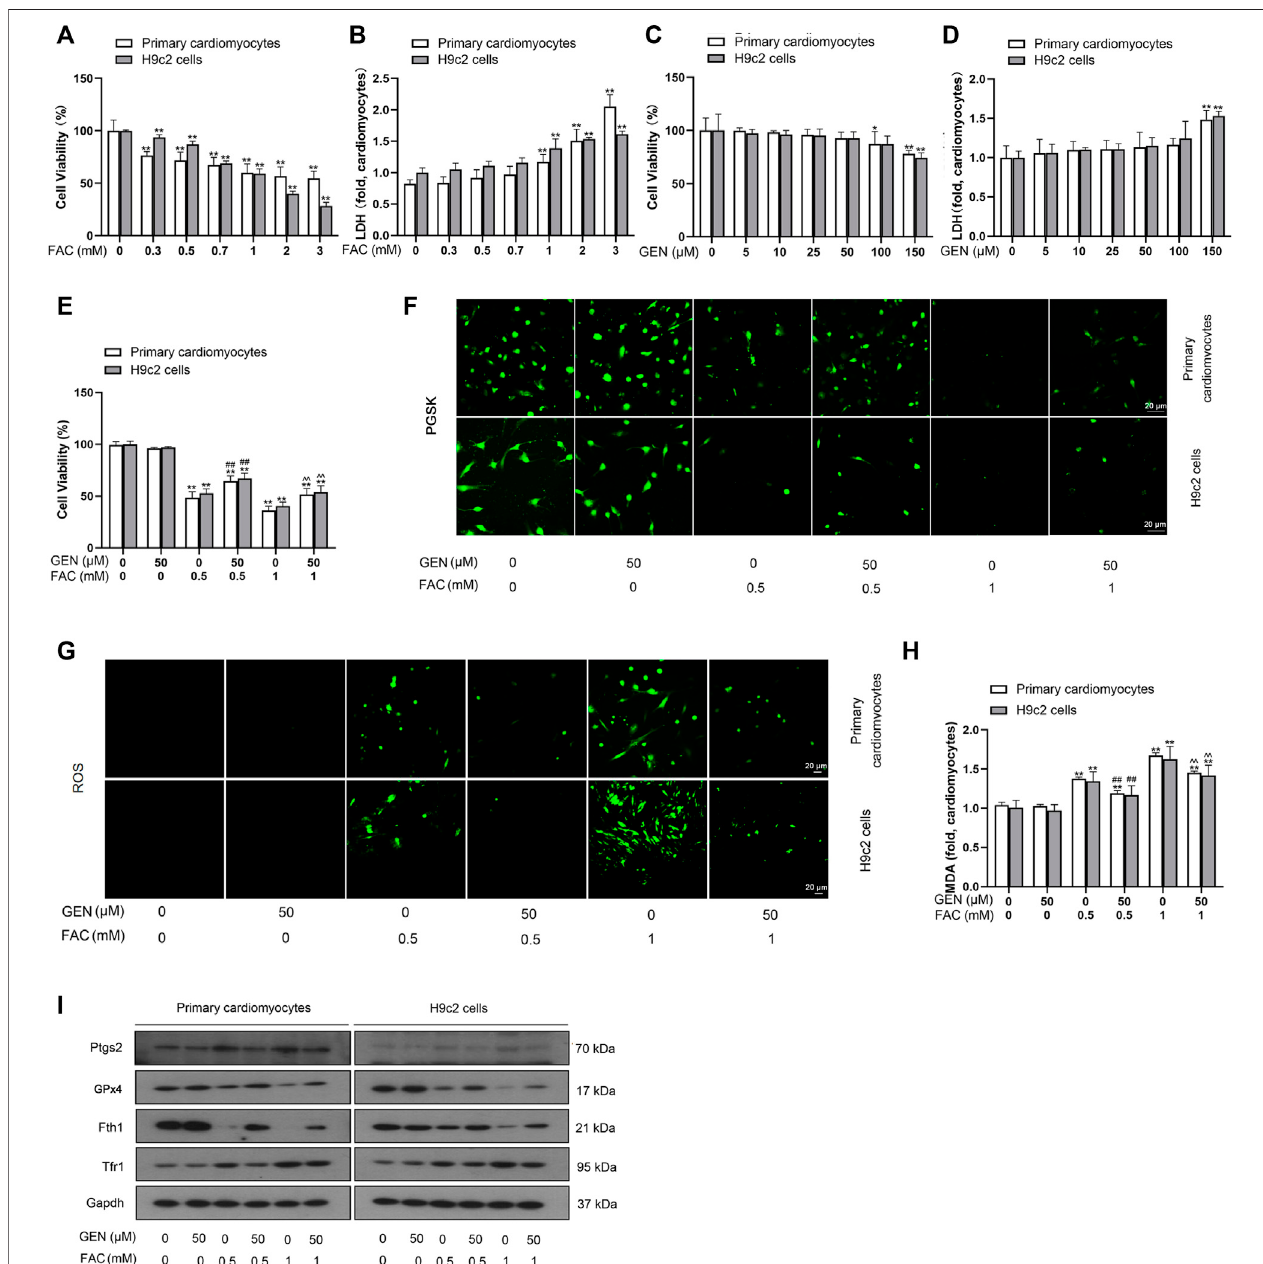
FIGURE 1 | FAC induces ferroptosis and oxidative stress injury in cardiomyocytes, which are reversed by GEN treatment. (A,B) Viability and toxicity of primary cardiomyocytes and H9c2 cells treated with different concentrations of FAC for 24 h. (C,D) Viability and toxicity of primary cardiomyocytes and H9c2 cells treated with various doses of GEN. (E) Viability of cardiomyocytes treated with 50 μ m GEN after treatment with 0.5 or 1 mM FAC. (F) Iron level in FAC-induced cells with GEN treatment. (G) ROSgeneration(green)inFAC-pretreatedcellstreatedwithGEN. (H) MDAlevelinFAC-treatedcellsaftertreatmentwithGEN. (I) Proteinexpression levelsofPtgs2,GPx4,Fth1,andTfr1incardiomyocytespretreatedwithFACandthentreatedwithGEN.Datawereexpressedasmean±SD( n =5).* p < 0.05,** p < 0.01 vs. Control group; ## p < 0.01 vs. 0.5 mM FAC group; ^^ p < 0.01 vs. 1 mM FAC group. Scale bar = 20 µm.